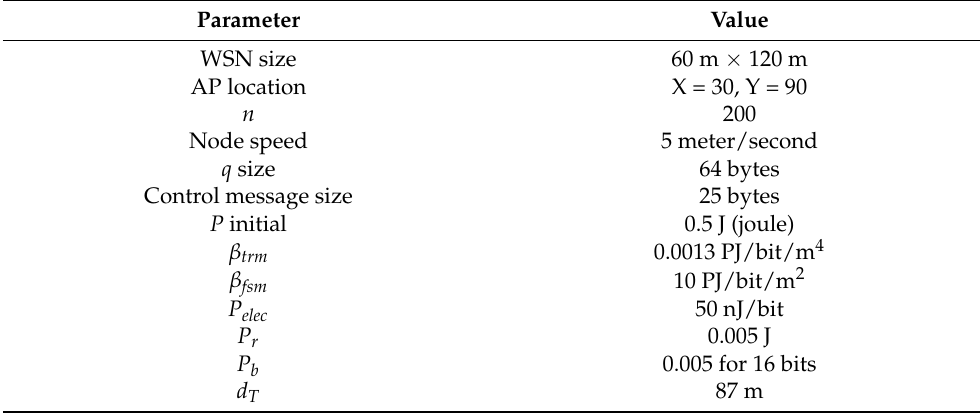
Table 3. Simulation parameters